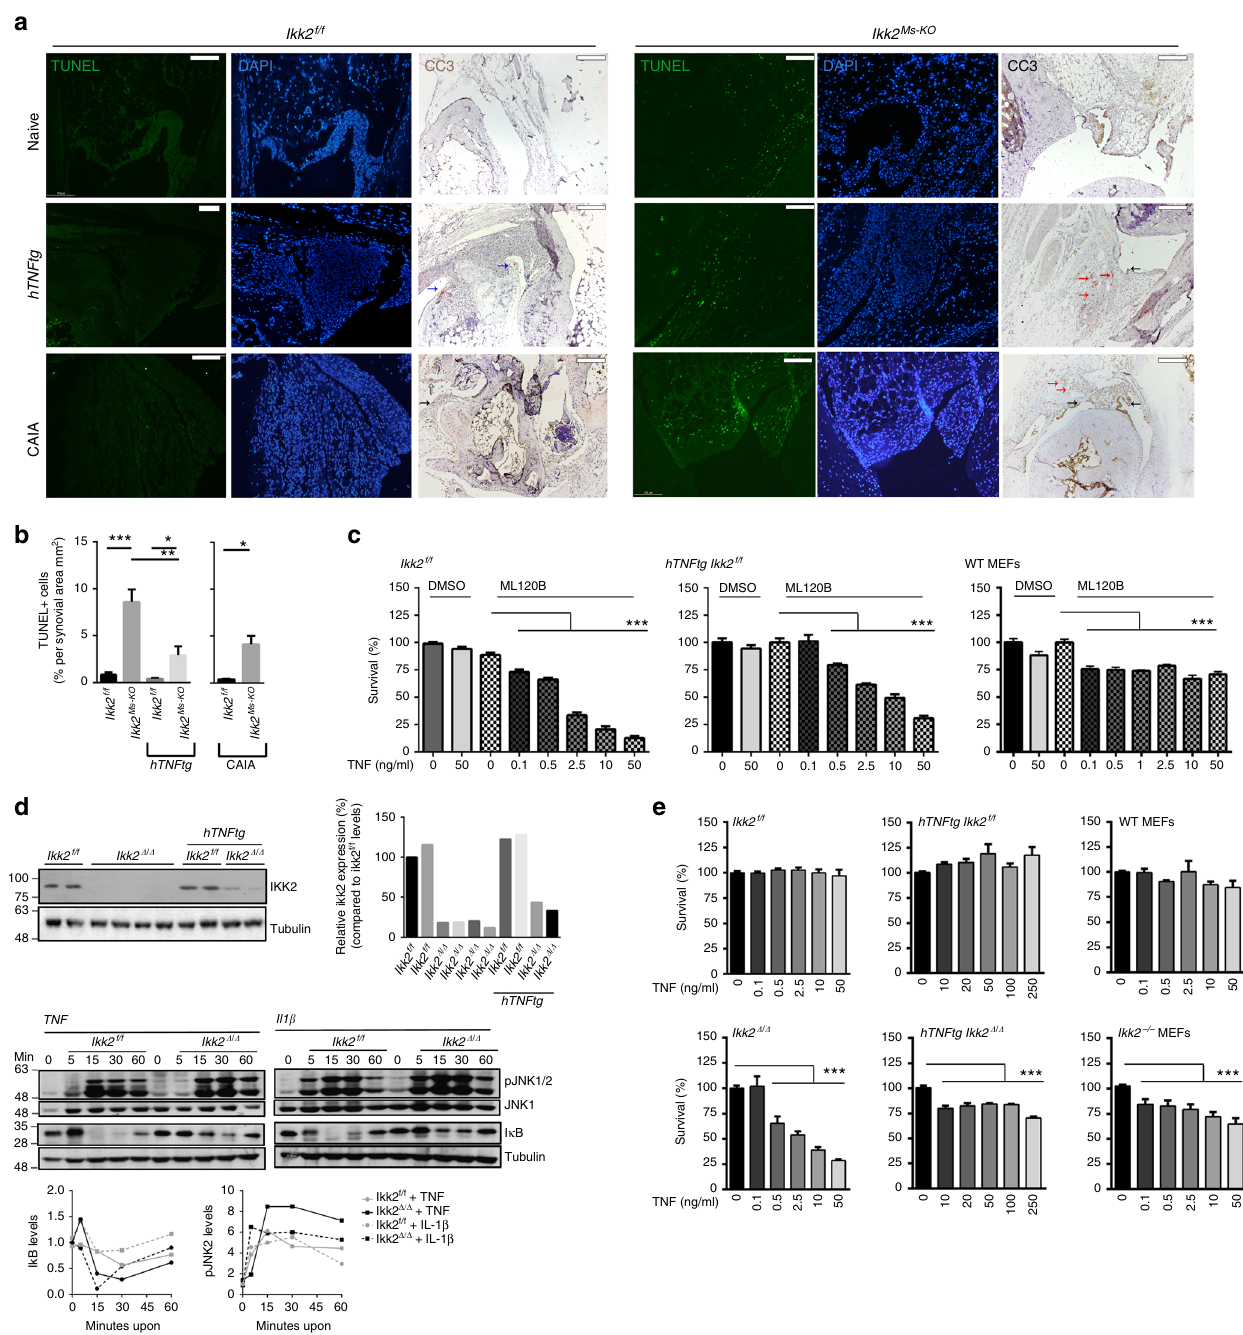
Fig. 3 Increased death sensitization of Ikk2-de fi cient SFs in TNF-mediated signals. a Representative images depicting TUNEL+ or CC3+ cells in sections of Ikk2 f/f and Ikk2 Ms-KO mice (naive, hTNFtg (week8) or CAIA-treated (D8)) ( n = 6 per genotype). Note the CC3+ cartilage cells (blue arrow), lining (black) and sublining (red) SFs, and other cells (open arrow) within necroptic areas. b Quantitation of TUNEL+ cells found in synovial membrane area of Ikk2 f/f and Ikk2 Ms-KO in naive ( n = 5 – 7) and arthritic conditions ( hTNFtg ( n = 4 – 7); CAIA ( n = 4)). c Survival rates of Ikk2 f/f , hTNFtg Ikk2 f/f SFs, and WT MEFs treated with different TNF concentrations, in the presence or absence of ML120b inhibitor (representative experiment, n = 5). d Representative immunoblot of IKK2 expression after the application of TAT-Cre in SF cultures derived from Ikk2 f/f and hTNFtg Ikk2 f/f mice, and IkB degradation and JNK1/2 phosphorylation patterns after TNF or IL-1 β treatment of Ikk2 -de fi cient SFs. Relative quantitations are depicted for each blot. e Representative survival rates of Ikk2 Δ / Δ and hTNFtg Ikk2 Δ / Δ SFs and Ikk2 − / − MEFs and control Ikk2 f/f and hTNFtg Ikk2 f/f SFs and WT MEFs treated with different TNF concentrations ( n = 15, 4 experiments). Scale bar: 100 μ m. Data are presented as the mean ± SEM. * P < 0.05, ** P < 0.01, and *** P < 0.001, by two-tailed Student ’ s t -test ( b ) or one-way ANOVA ( c , d ). Unprocessed original scans of blots are shown in Supplementary Fig.